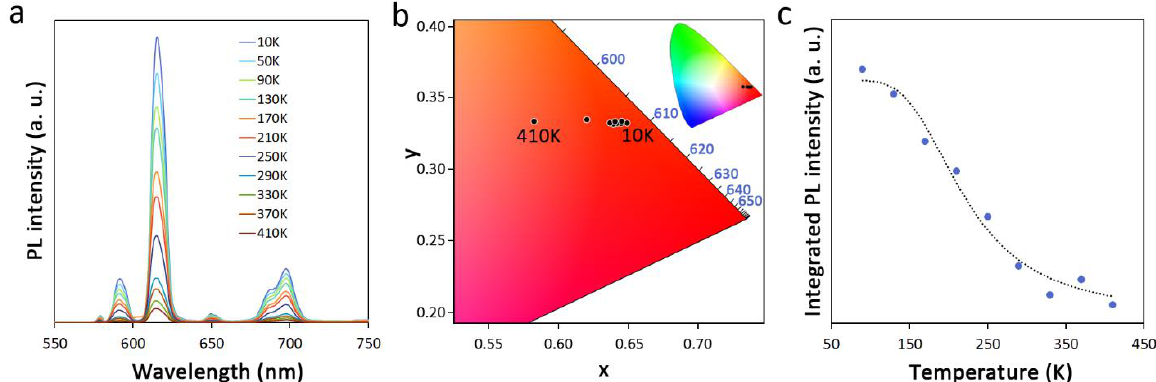
Figure 5. ( a ) Temperature-dependent PL spectra of PHTF-3Eu ( λ ex = 300 nm); ( b ) Magnification of a portion of the CIE diagram of PHTF:Eu in the 10 – 410 K temperature range. The whole diagram is reported in the inset; ( c ) Plot of the integrated PL intensity vs. temperature for the emission band centered at 612 nm (I 02 , 5 D 0 → 7 F 2 ) of PHTF-3Eu. The blue circles represent the experimental data, and the dotted curve represents the best fit according to Equation (4) (R 2 = 0.975).